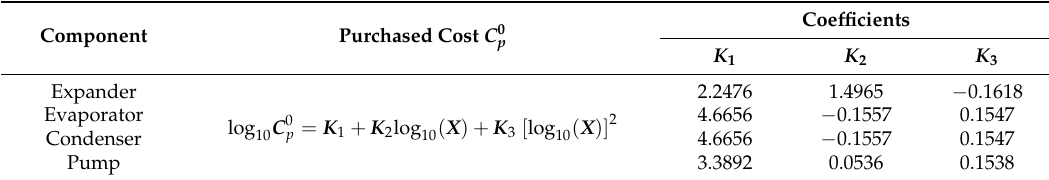
Table 2. Coefficients for Different ORC Components [199].